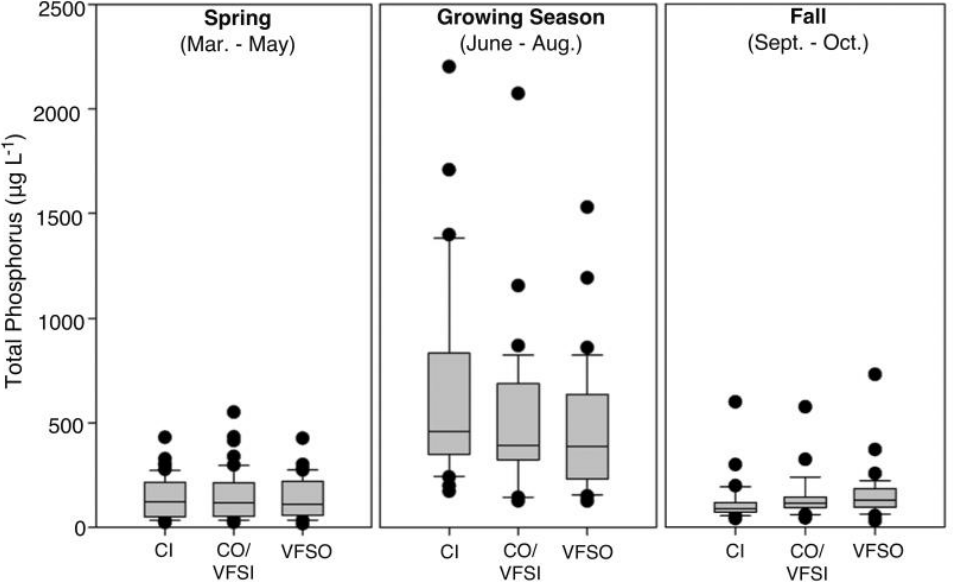
Figure 7. Total P concentrations in surface water by season from data collected from 2015 to 2017 at the same field sites as described in this research (modified from Vanrobaeys et al. [16]). CI represents P concentrations in water samples collected at the inflow to the control sites, CO/VFSI represents P concentrations in samples collected leaving the control sites and entering the VFS sites, and VFSO represents P concentrations in water samples collected at the outflow of the VFS.